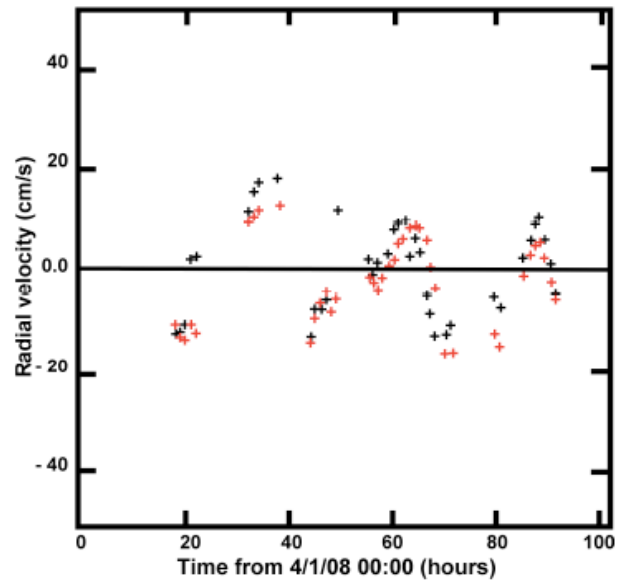
Figure 10. Time series of radial velocities measured at the point shown in Figure 9 by COMM (Black) and Drifter